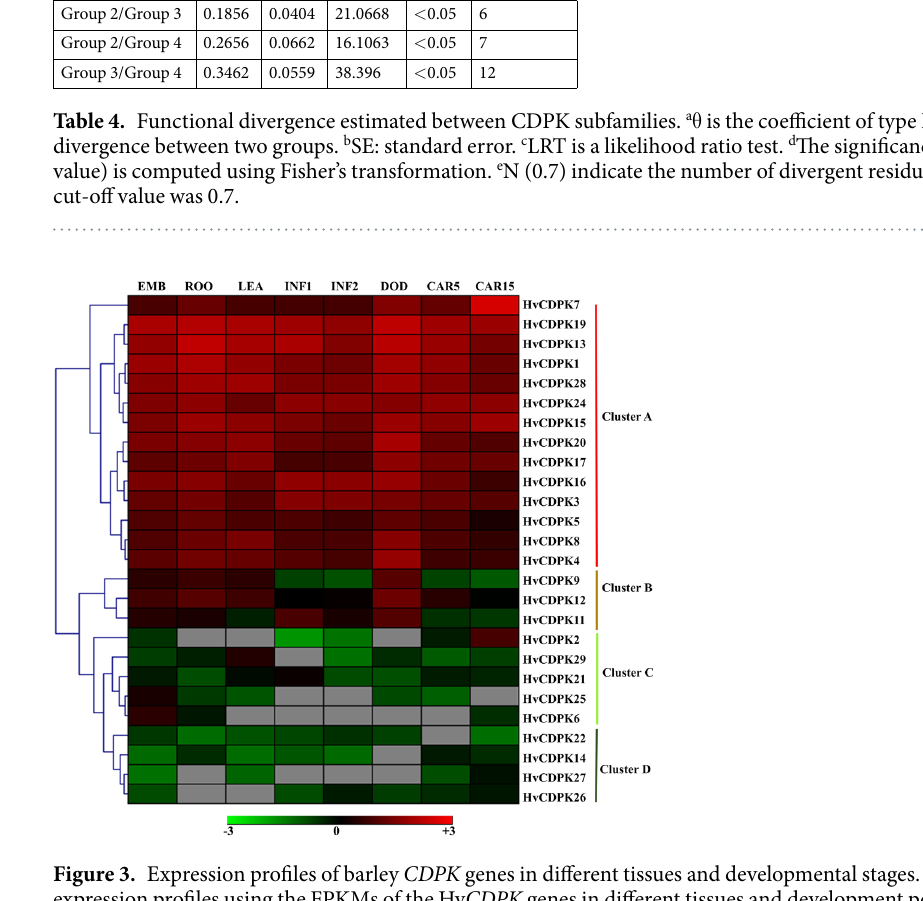
may be involved in the growth and development of these organs. However, four CDPK genes from Cluster D had very low expression levels throughout the sample set. Expression profiles of Hv CDPK genes during MeJA treatment. Biotic and abiotic stresses are impor- tant restrictive factors affecting plant growth and development. The identification and study of plant resistance genes can be addressed at the molecular level using gene expression profiles to reveal the mechanisms of plant resistance. To analyse the responses of Hv CDPK s to MeJA treatment, the expression levels of 28 Hv CDPK s were examined by qRT-PCR. As shown in Fig. 4, the expression levels of 28 Hv CDPK s showed different tendencies. Further, we divided the Hv CDPK s genes into four subfamilies according to how they clustered in the phylogenetic tree to test for potential functional divergences among the four groups (Fig. 4). In Group 1, 8 of the 10 Hv CDPK genes, with the exceptions of Hv CDPK10 and Hv CDPK11 , showed lower expression levels in MeJA-treated plants than in controls, and a similar trend was found in Group 4. However, transcripts of Hv CDPK s in Group 2, except Hv CDPK25 and Hv CDPK1 , increased when plants were treated with MeJA. Meanwhile, the expression levels of all the Hv CDPK genes in Group 3 were greater than those of the untreated plants after 2 h of MeJA treatment. In particular, expression levels of Hv CDPK22 were upregulated by more than 70-fold (12 h) compared with their respective levels at 0 h. These results indicated that the 28 Hv CDPK s had different response patterns to the same stimulus (Fig. 4). Additionally, combined with analyses of functional divergence (Table 4), this suggested that